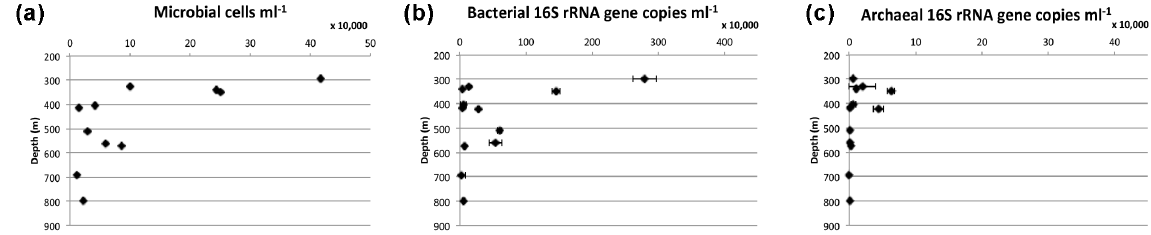
Figure 2. The concentration of (a) microbial cellsmL − 1 determined by epifluorescence microscopy and the estimated concentration of (b) bacterial and (c) archaeal 16S rRNA gene copiesmL − 1 groundwater determined by qPCR in water conductive fractures situated at different depths in the Olkiluoto bedrock.